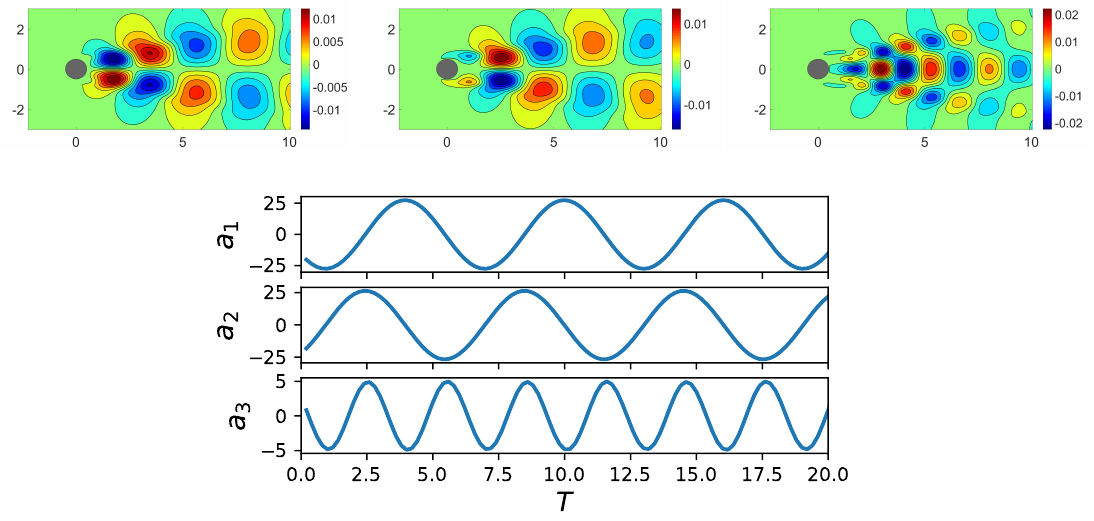
Figure 5. Isocontours of the three most energetic modes (first row from left to right) and time evolution of the first three POD coefficients (second row) for the cylinder wake flow at Re =